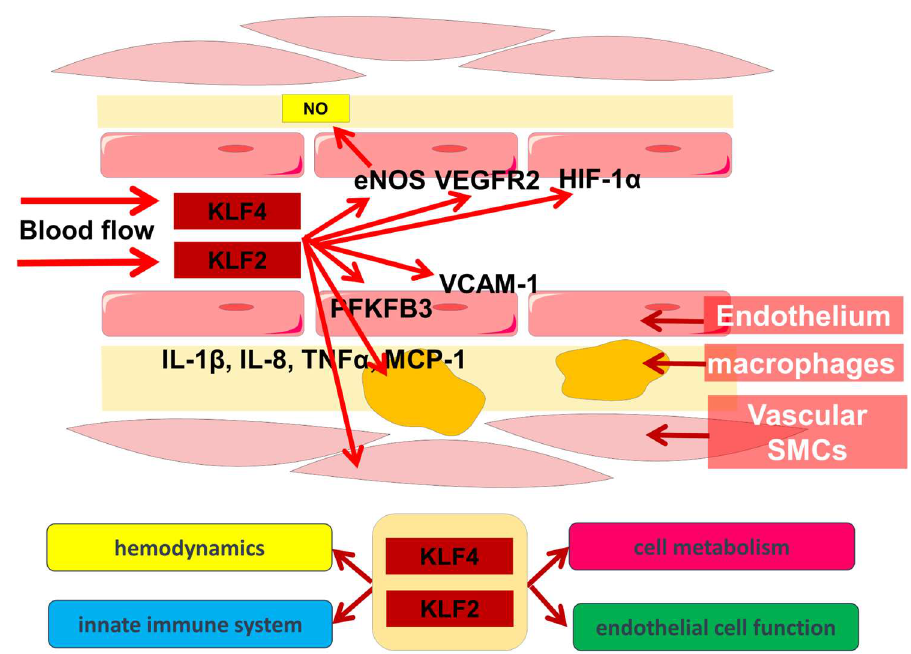
Figure 1. Involvement of KLF2 and KLF4 in hemodynamic, metabolic, and innate immune system cross-links.